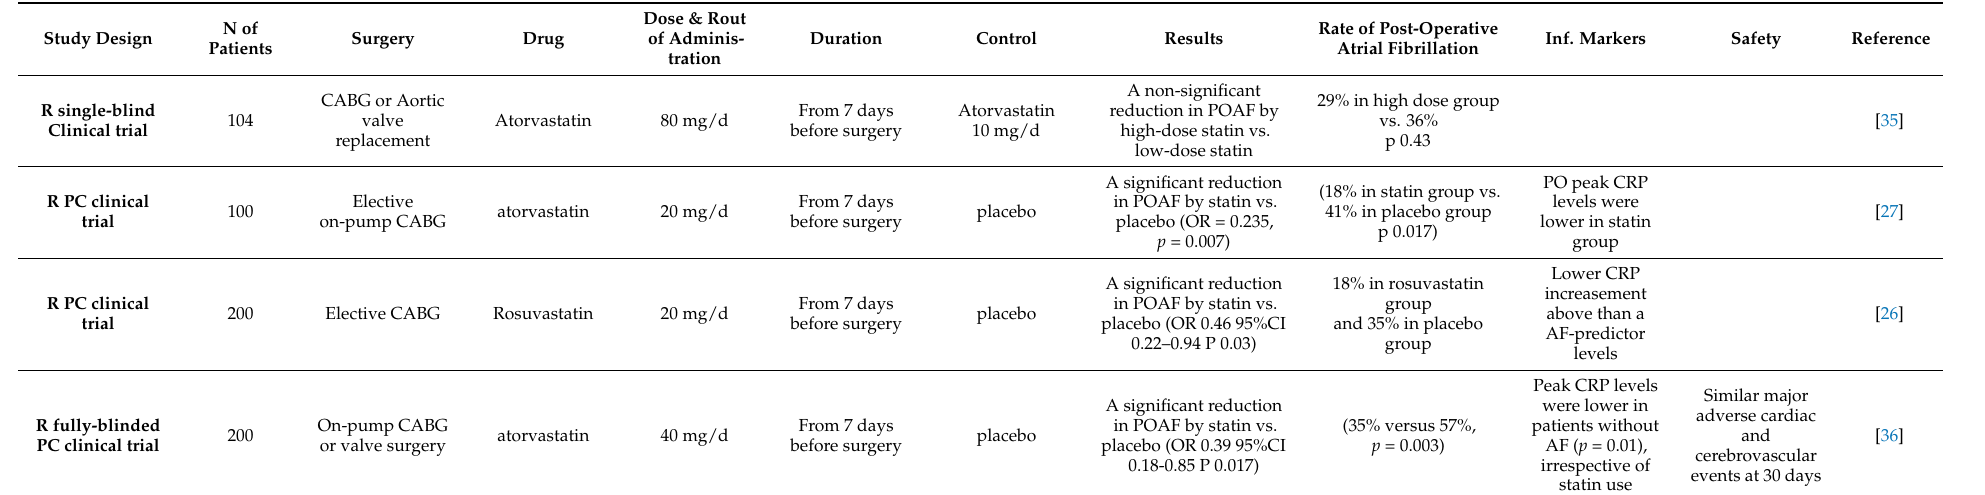
Table 2. Meta-analyses evaluating the effect of statins on the prevention of post-operative atrial fibrillation. N and Design of Included Studies Evaluating